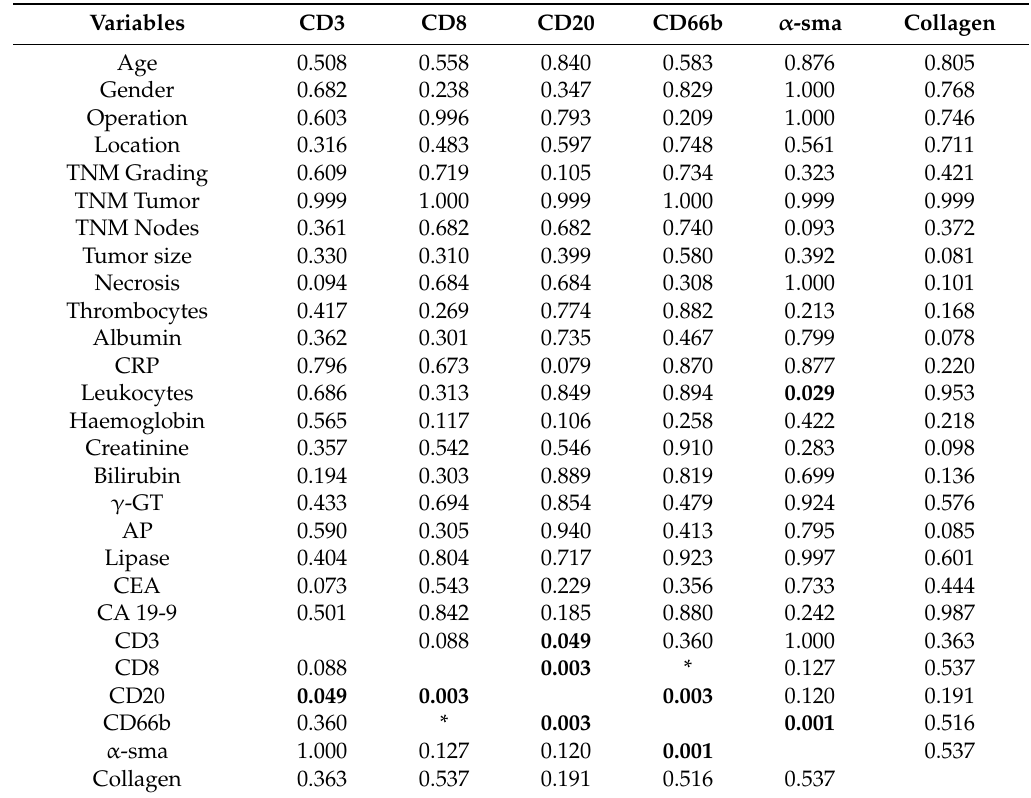
Table 2. Binary logistic regression of the different variables presented at time of resection. p -values < 0.05 were defined as statistically significant and appear in bold. * p <